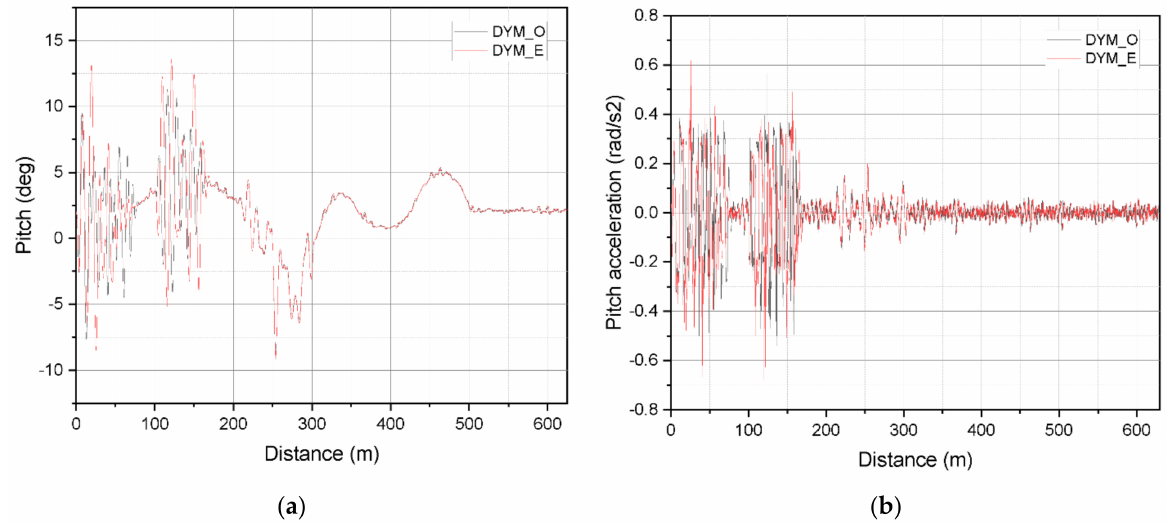
Figure 8. The comparison of pitch status: ( a ) pitch angle status; ( b ) pitch acceleration